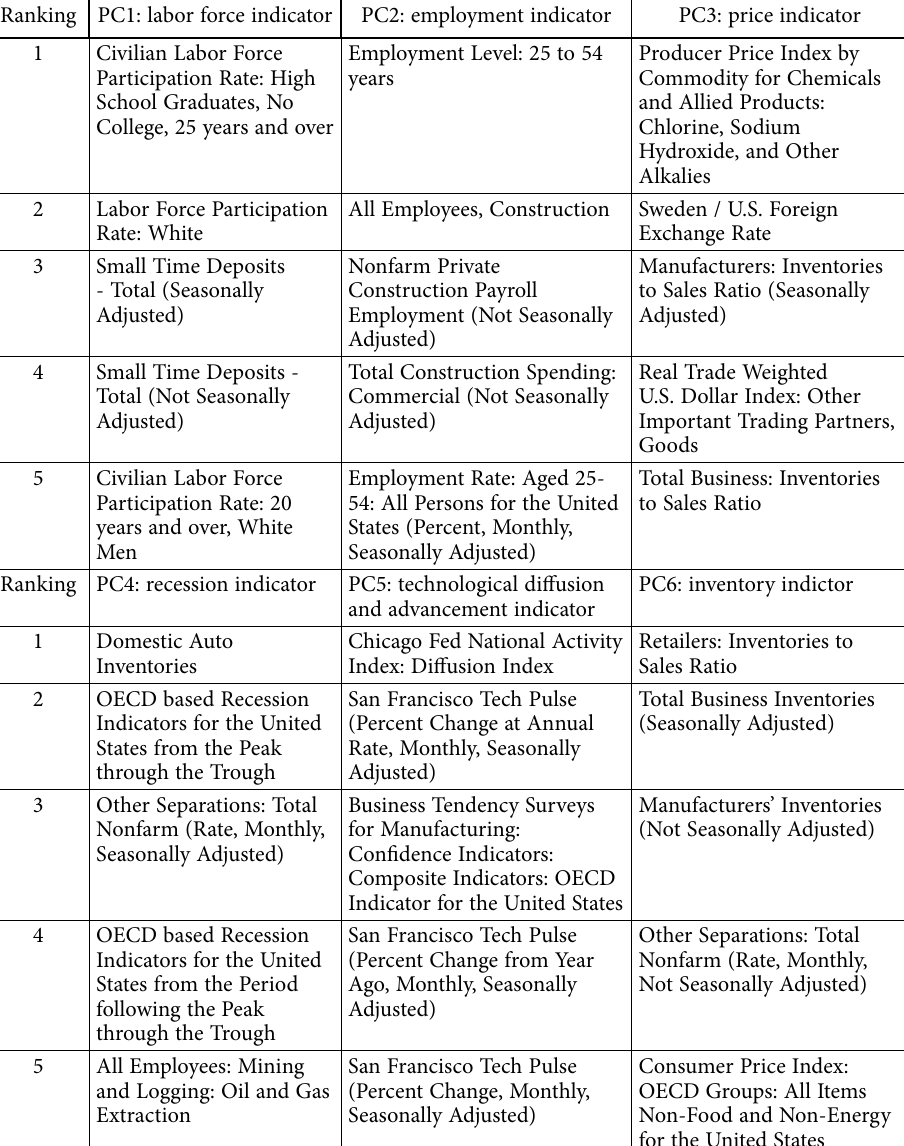
Table 3. Top five macroeconomic variables for each principle